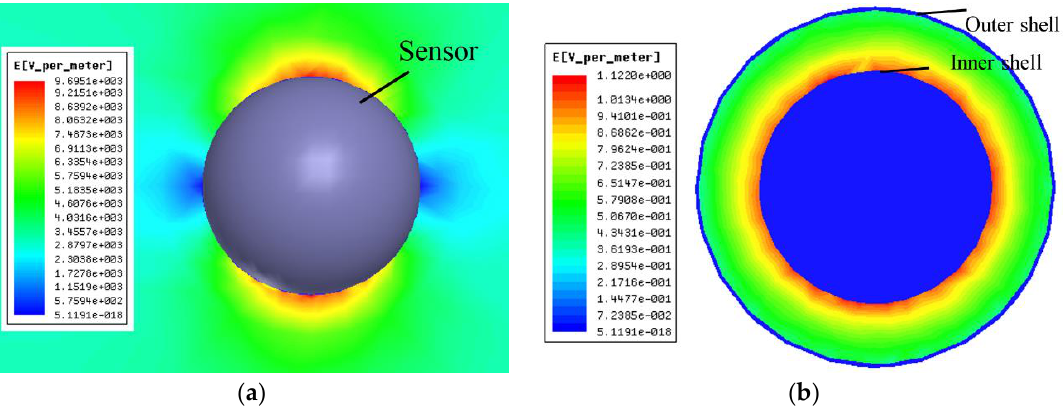
Figure 5. The distribution of electric field. ( a ) Around the sensor. ( b ) Inside the sensor.